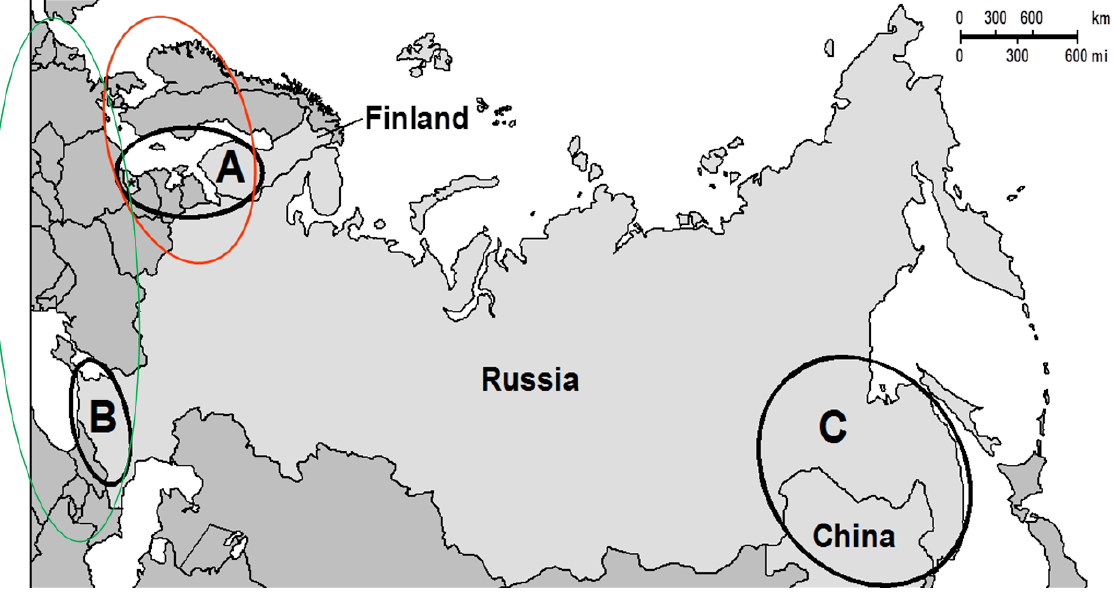
Figure 1. In the population of northern Europe ( red circle ), 3ADON molecular chemotype of F. graminearum is dominant, while 15ADON molecular chemotype is more common in the population of southern and central Europe ( green circle ) including Turkey and northwestern Iran. F. ussurianum (3ADON genotype) and F. vorosii (15ADON genotype) were also found in Russian Far East. A , B and C represent the three main areas, where F. graminearum isolates were collected by Yli-Mattila et al. [4] for chemotype